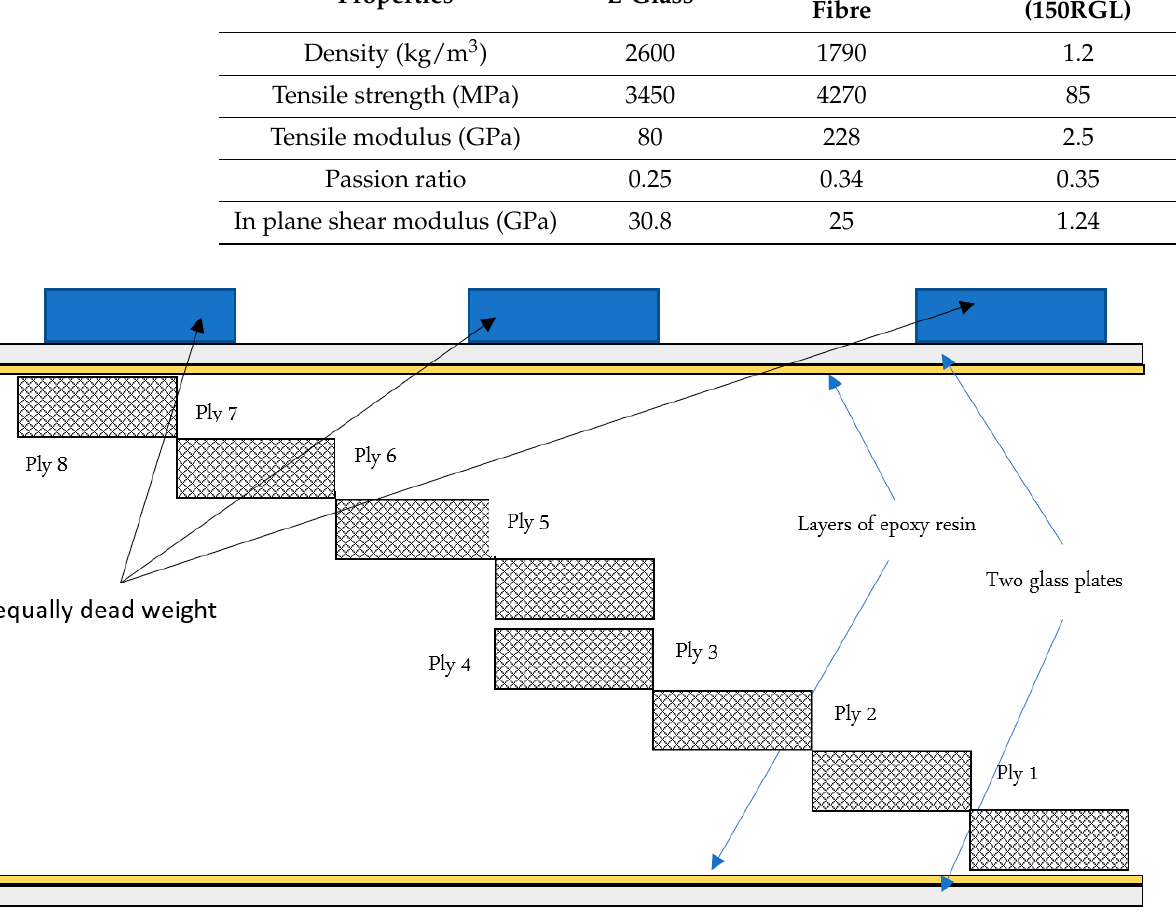
Figure 3. Schematic drawing of laminate setup.